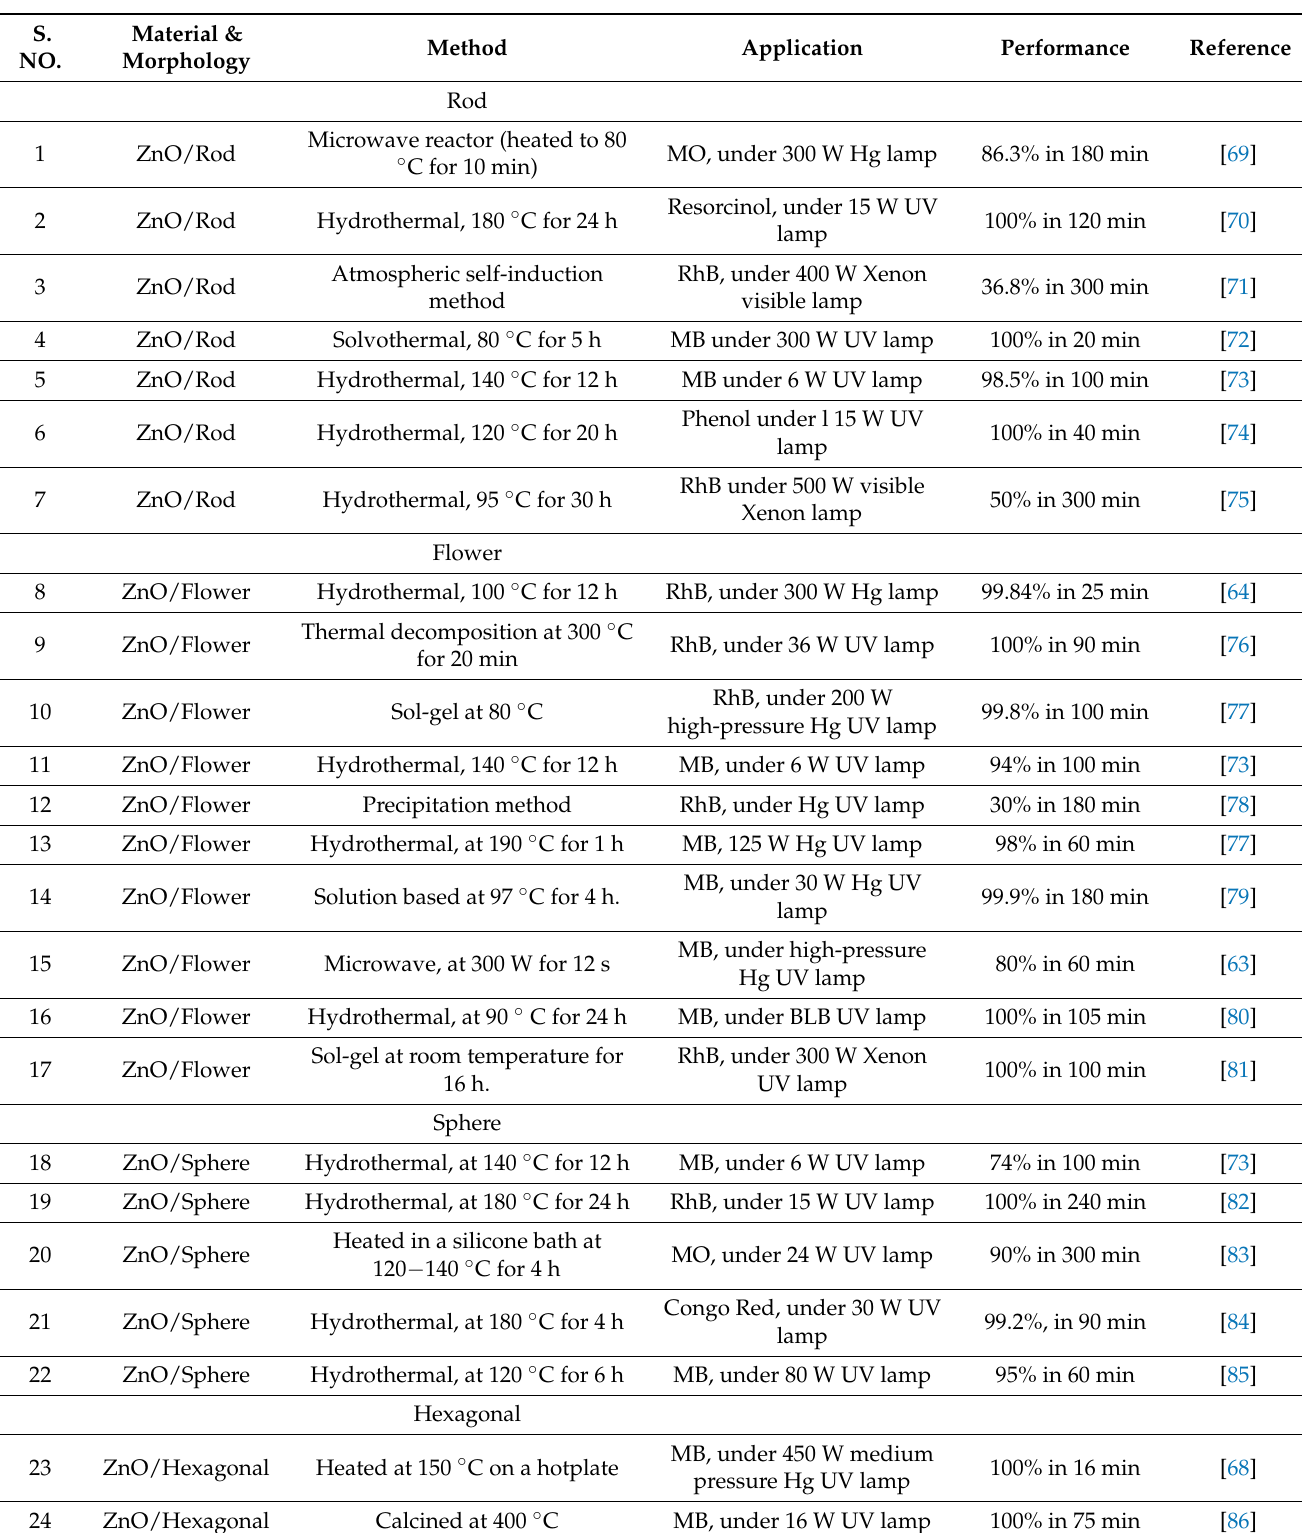
Table 2. Comparative study of different nano morphologies of nanostructured